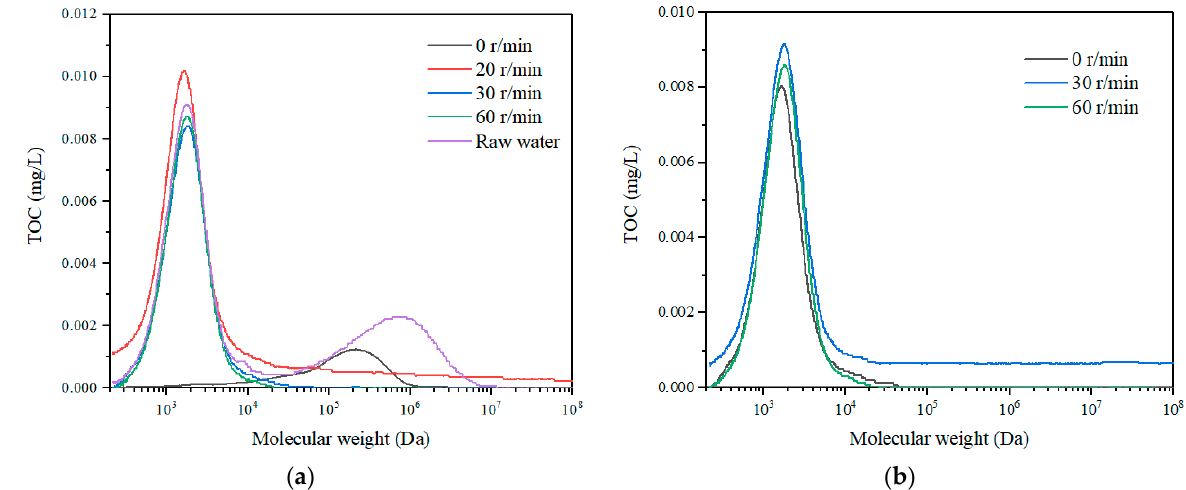
Figure 5. Molecular weight distribution (TOC detection) with different rotation speeds in SA solution, ( a ) 1 h, and ( b ) 4 h.